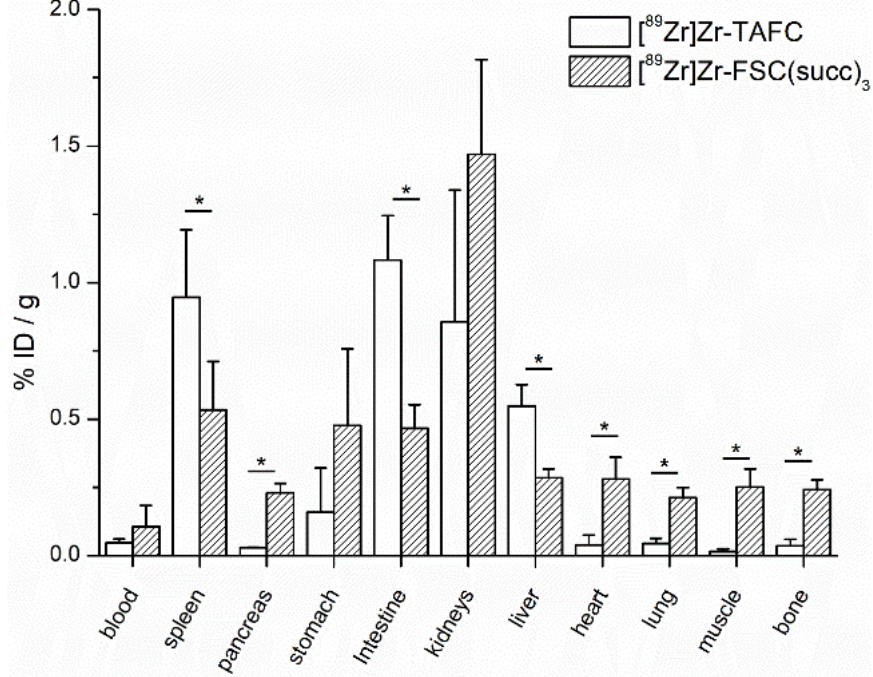
Figure 5. Comparison of biodistribution data of [ 89 Zr]Zr-FSC(succ) 3 (4.8 µ g, 1.5 MBq, n = 4) with [ 89 Zr]Zr-TAFC (4 µ g, 1.5 MBq, n = 4) at 6 h post infection (p.i.) in BALB/c mice. * indicates significant differences between the two compounds ( p < 0.05).